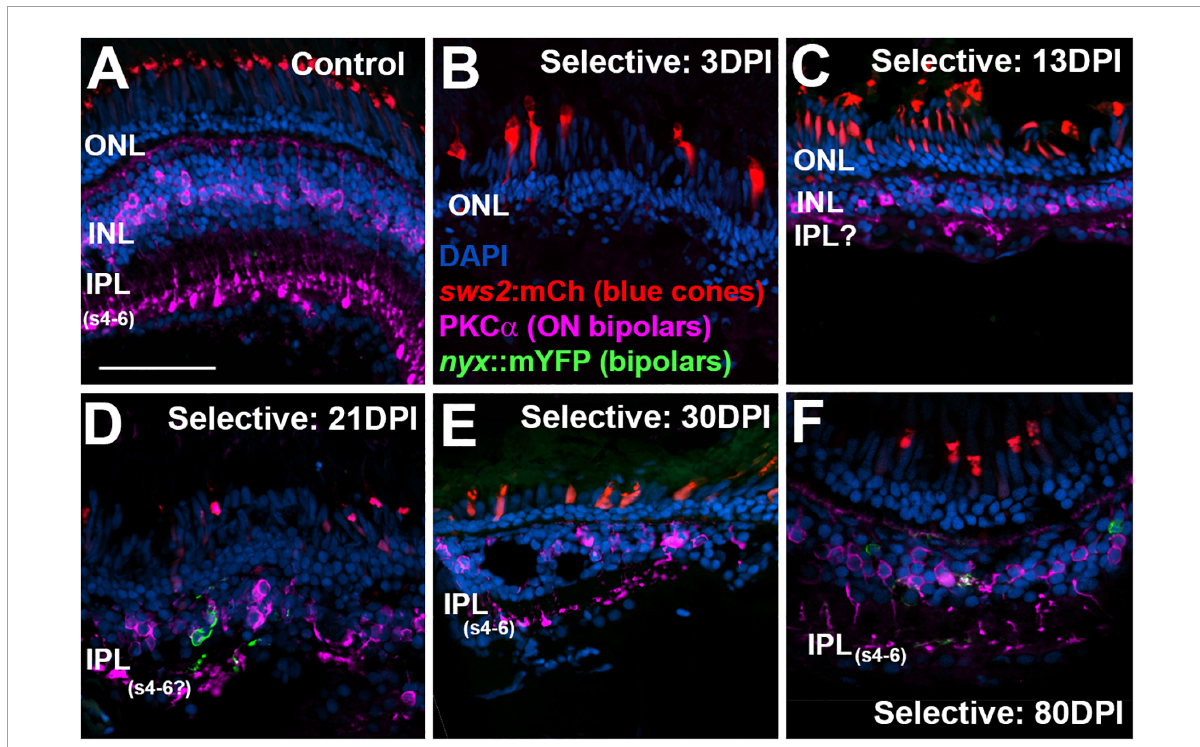
FIGURE9 Time-course of restoration of PKC α + ON bipolar neurons and their synaptic terminals following selective lesion. Tissues were processed for indirect immunofluorescence and imaging after ERG recordings. Retinas were of zebrafish transgenic for sws2 :mCherry (in blue cones) and nyx :mYFP (in a subset of bipolar neurons); in this line the mYFP is expressed in a variegated manner (Schroeter et al., 2006), therefore not all of the panels in this figure show the YFP reporter. (A) . Control retina displaying characteristic ON-bipolar synaptic terminals within the deep (s4-6) layers of the inner plexiform layer (IPL). (B) . Retinal tissue at 3 days post-injury (DPI), demonstrating loss of inner retinal structure, and particularly of PKC α + ON-bipolar neurons. Photoreceptors, including sws2 :mCherry + blue cones, are not damaged by the selective lesion. (C–H) . Regenerating retinas at 13 (C) , 21 (D) , 30 (E) , and 80 DPI (F) . Some features of IPL emerge by 13 DPI (C) , but PKC α + ON bipolar axon terminals are not entirely localized to regions that are recognizable as sublaminae s4-6. At 21 and 30 DPI, PKC α + terminals occasionally